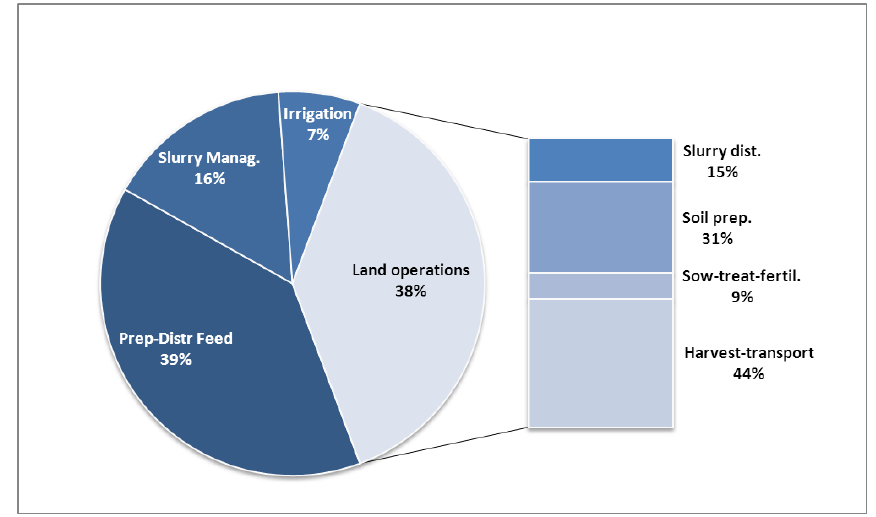
Figure 1. Distribution of electricity requirements among on-farm operations.